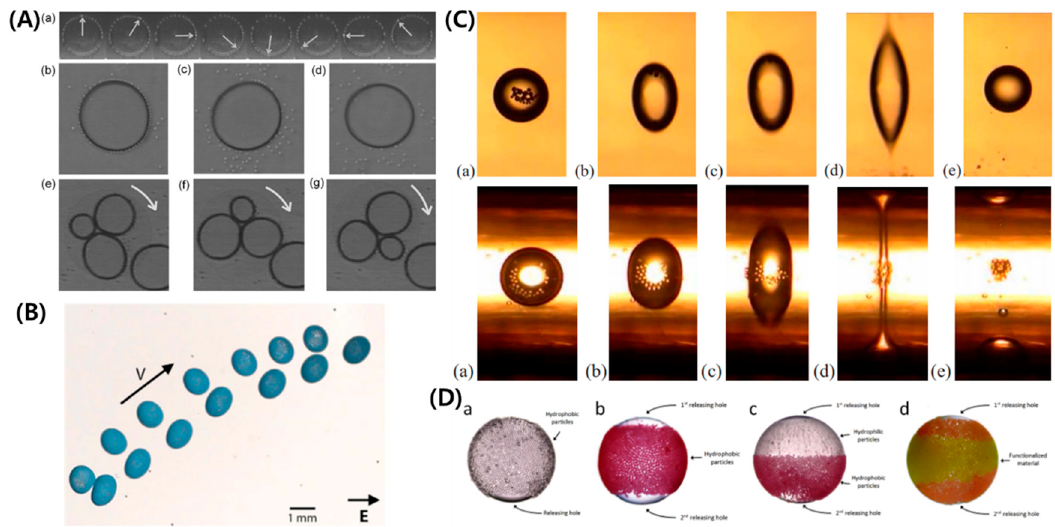
Figure 11. Applications of EHD of emulsion droplets. ( A ) Rotation of glass-sphere-covered air bubbles under a DC electric field [166] . ( B ) Pickering droplet propulsion [92] . ( C ) Removal or collection of particles from a w/o emulsion using an electric field [170] . ( D ) The releasing holes for material transportation from/to the capsule [171] .